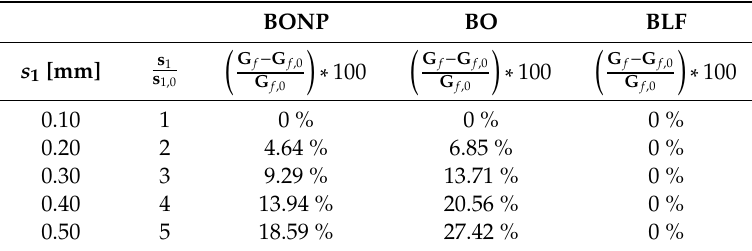
Table 3. Variation of fracture energy for the BONP, BO and BLF models.